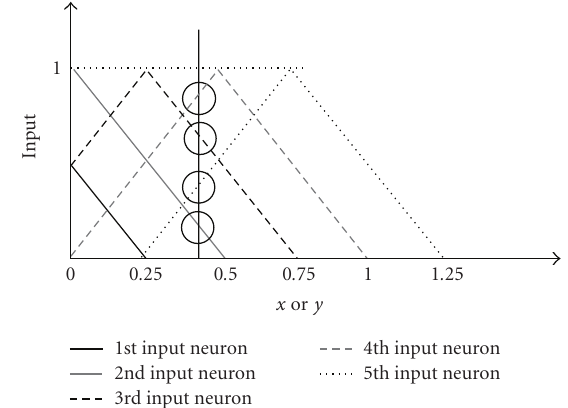
Figure 2: Localized input signals. Each input signal responds when the object or agent exists around one specific location in x or y coordinate. This localized representation helps to learn a strong nonlinear